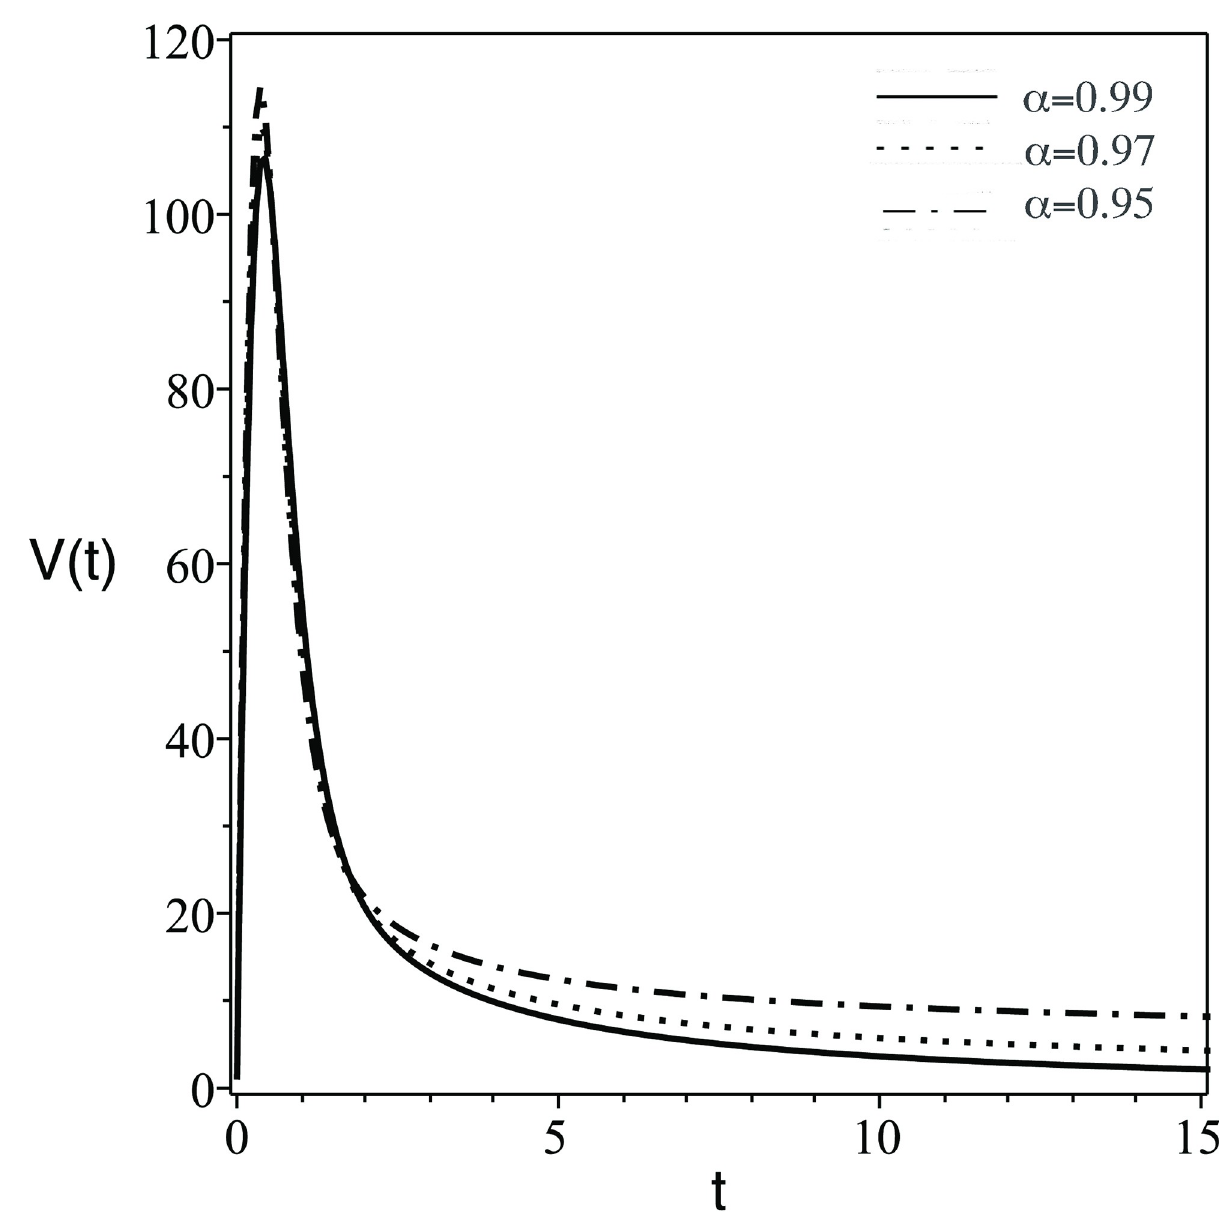
Fig 4. Same as Fig 1 but for the number of HIV virus in the blood, V ( t ).